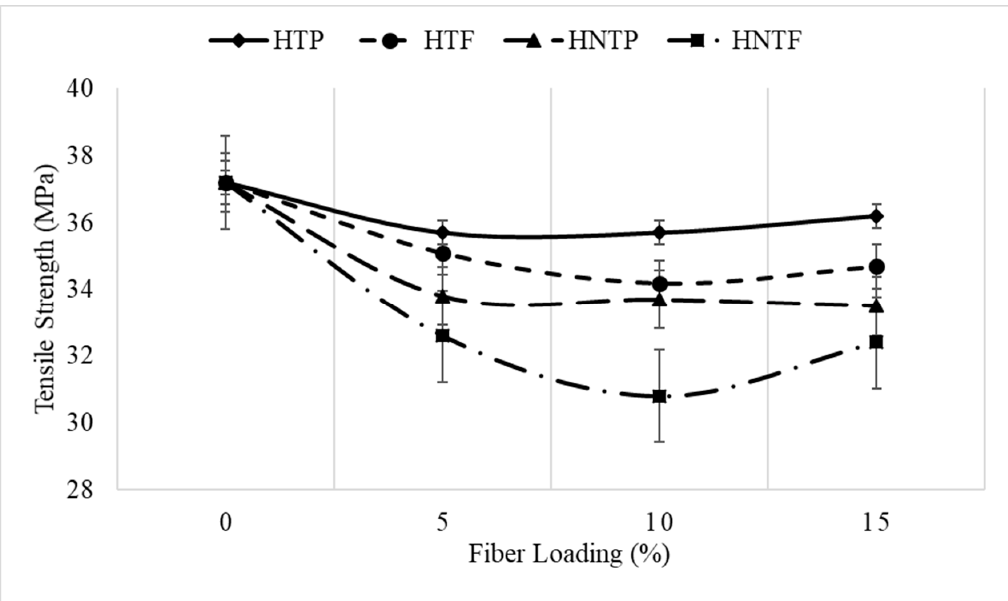
Figure 3. Effect of treatment and fiber loading on tensile strength. Figure 3. E ff ect of treatment and fiber loading on tensile strength.